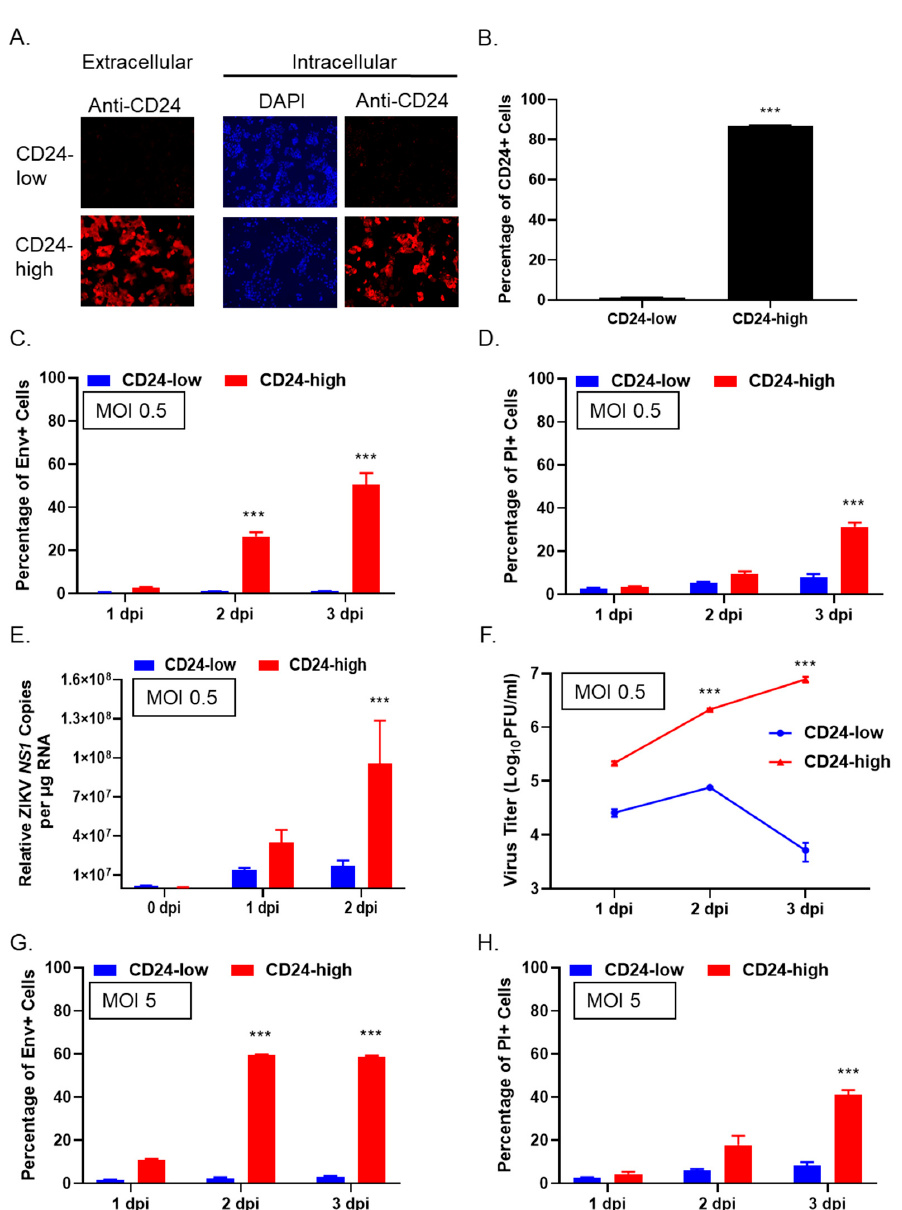
Figure 1. Ectopic expression of CD24 in SK-N-AS cells enhances low MOI spread of ZIKV infection. ( A , B ) CD24-low and -high cells were analyzed by 4; 6-Diamidino-2-pherylindole (DAPI) staining (blue) or immunostaining with anti-CD24 antibody (red) ( A ) or by flow cytometry ( B ) for CD24 expression. Data are a representation of two separate experiments. ( C – F ) CD24-low and -high cells were infected with ZIKV at a low MOI of 0.5. Flow cytometry was performed at indicated time points to determine the percentage of infected (Env+) cells ( C ) or non-viable (PI+) cells ( D ). Total cellular RNA was isolated from infected CD24-low and -high cells at indicated time points, and gene levels of NS1 were determined via qRT-PCR. Data are expressed as Relative ZIKV NS1 copies per µg of analyzed RNA ( E ). Media were harvested at indicated time points from the infected cell cultures and analyzed by plaque assays to determine levels of infectious virus. Viral titers were expressed as PFU/mL on a logarithmic scale and normalized to 10 6 infected cells ( F – H ). CD24-low and -high cells were infected at a high MOI of 5, and the percentage of Env+ ( G ) and PI+ ( H ) cells were determined at the indicated days post-infection (dpi). All figures’ values are the mean of three samples, with error bars representing standard deviation. *** indicates p -value <0.001.